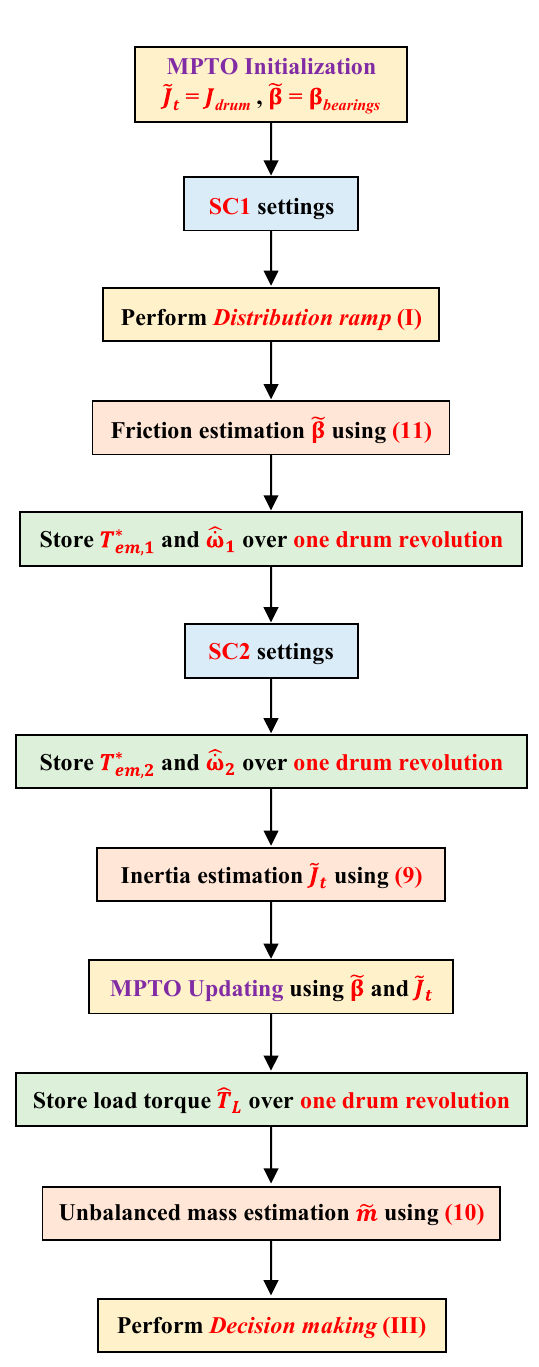
Figure 12. Flowchart of the proposed method.